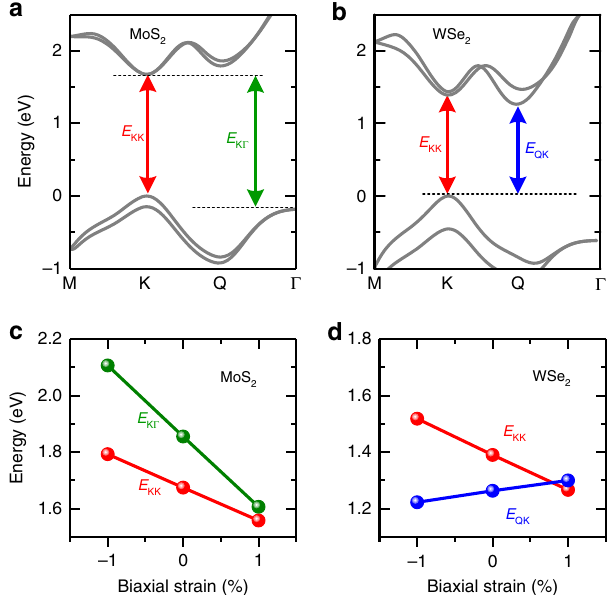
Fig. 3 DFT calculations of strained MoS 2 and WSe 2 monolayers. a , b The calculated band structures for monolayer MoS 2 ( a ) and WSe 2 ( b ) based on DFT. E KK and E K Γ ( E QK ) denote the direct and the indirect gaps in MoS 2 (WSe 2 ), respectively. c , d Strain-induced energy shifts in the direct and indirect gaps in monolayer MoS 2 ( c ) and WSe 2 ( d ). The calculations show that unstrained WSe 2 is an indirect gap material, which can be turned into a direct-gap material by applying tensile